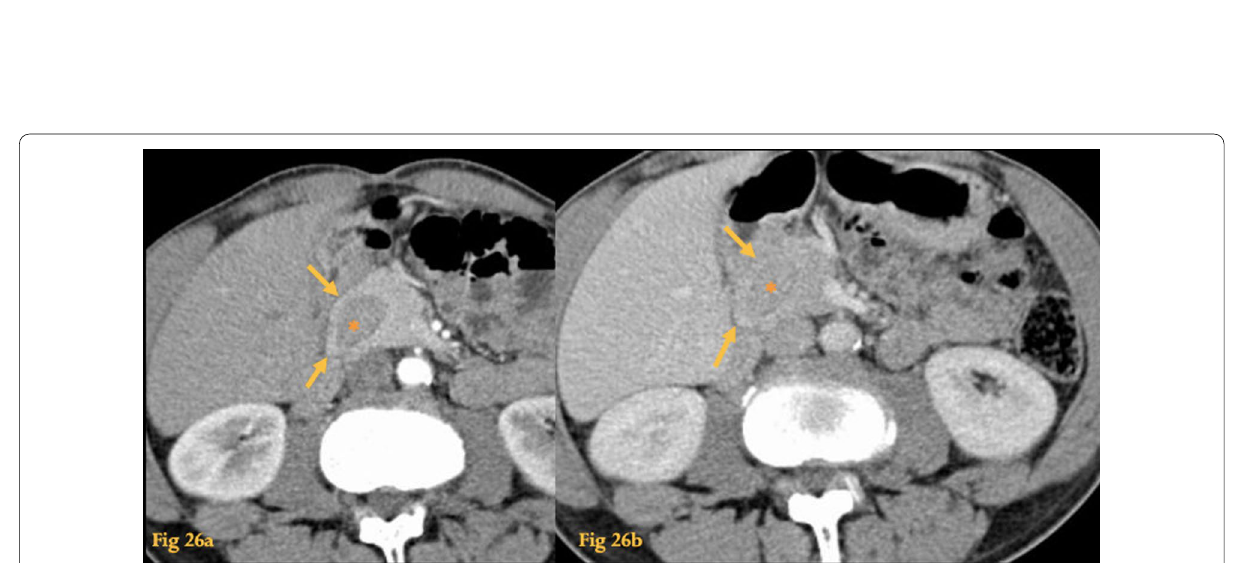
Fig. 26 Annular pancreas. Abdominal CT of an adult patient shows pancreatic tissue completely surrounding D2 (asterisk), in an annular fashion (arrows), with enhancement equal to the pancreas on both the arterial ( a ) and portal venous ( b )